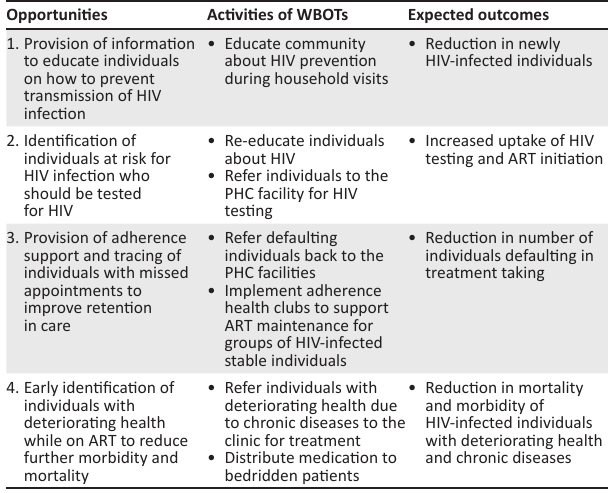
TABLE 1: Summary of potential contributions of WBOTs to the HIV programme